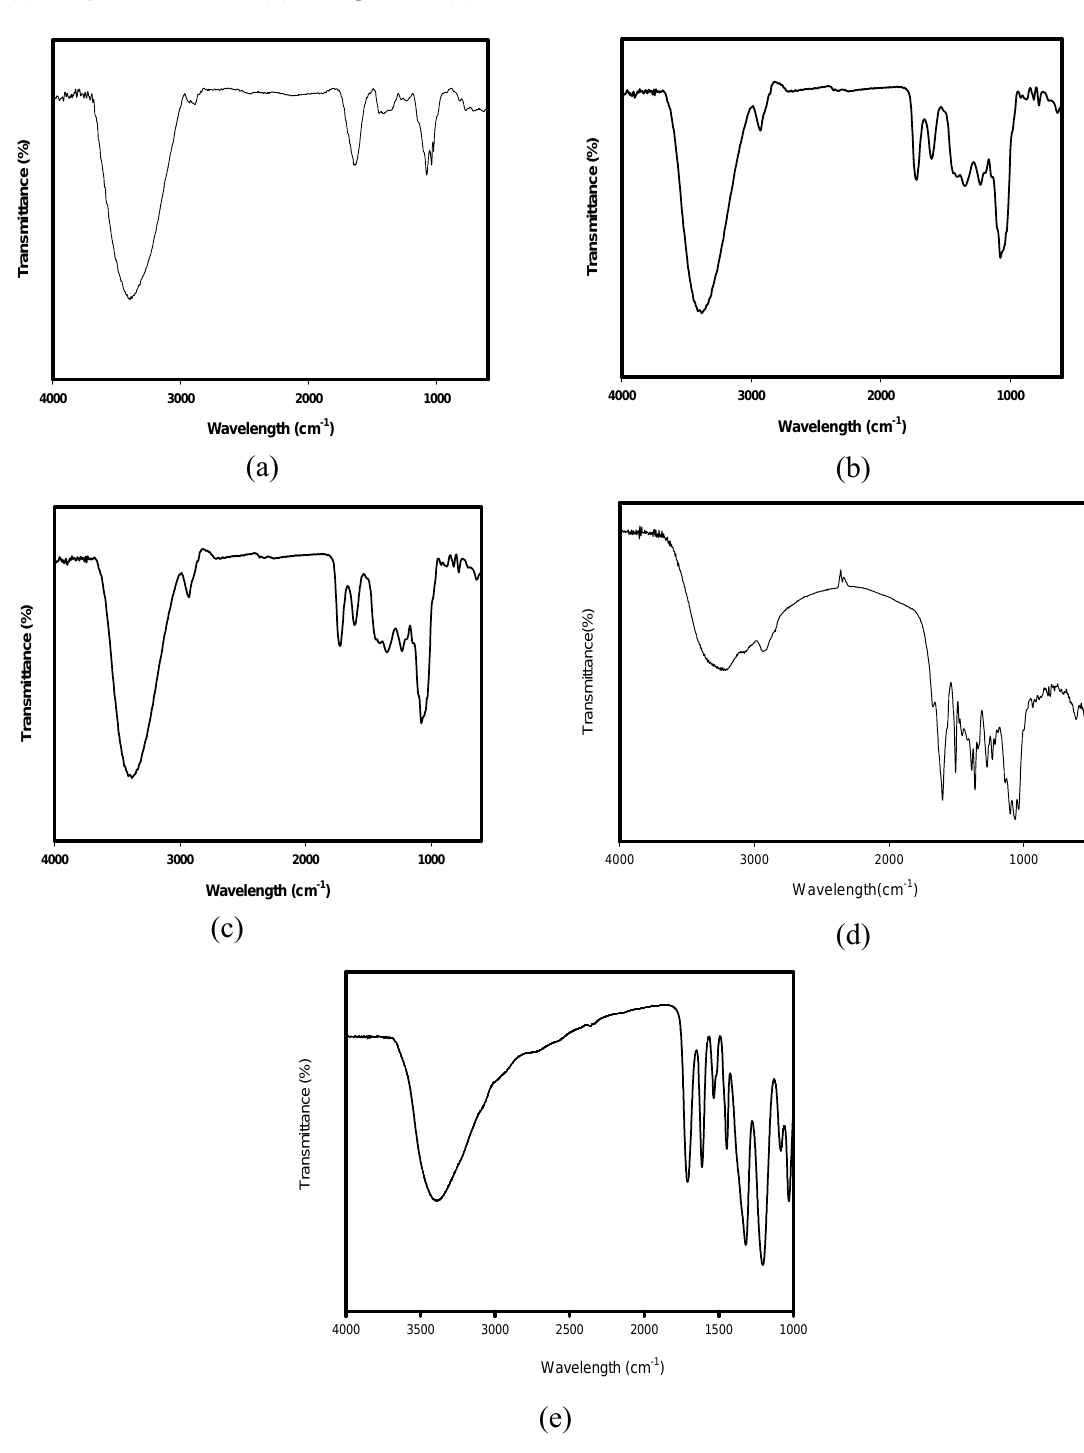
Figure 1 . Infrared spectra of extracted natural colorants: peony (a), pomegranate (b), clove (c), Coptis chinensis (d) and gallnut